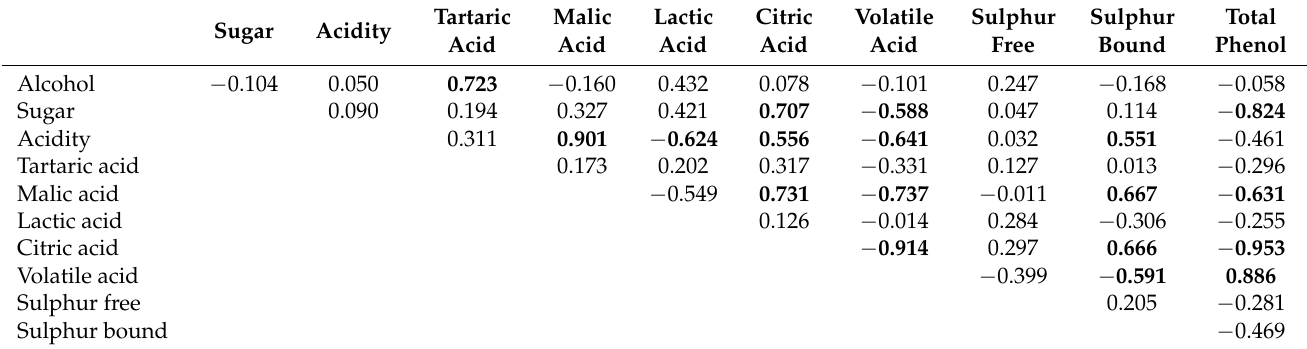
Table 8. Pearson correlation coefficients ( r ) amongst ten oenological measurements of white wine in twenty-one bentonite product treatments (Debrecen-Pallag, Hungary). Bold figures represent the significant ( p < 0.05) correlation coefficient values among parameter